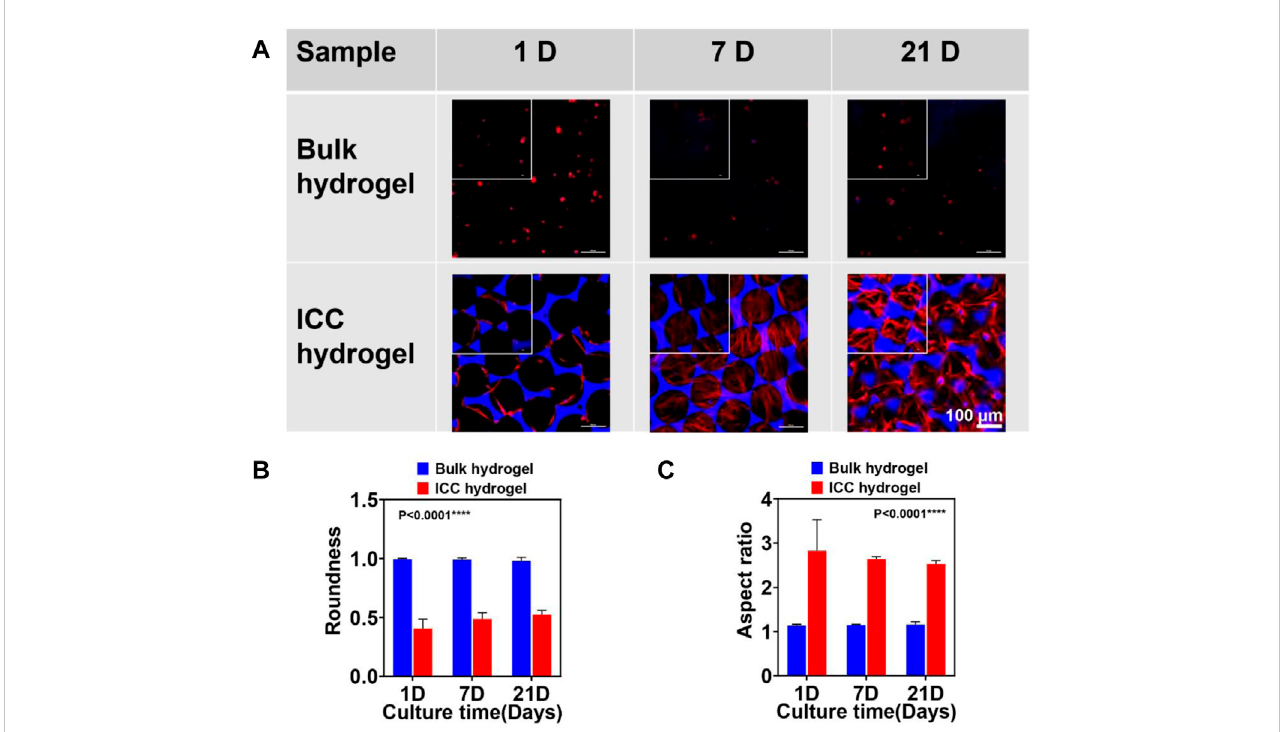
FIGURE 6 (A) Cell morphology in GelMA bulk and ICC hydrogels on different culture times (1, 7, and 21 days) con fi rmed via confocal microscopy. F-actin stained with Alexa Fluor 488 phalloidin (red) and nuclei stained with 4 ′ , 6-Diamidino-2-phenylindole dihydrochloride (DAPI, blue). Large window images (20 × lens; scale bar is 100 μ m). Small window images (40 × Lens, Scale bar is 100 μ m) (B,C) Cell roundness and aspect ratio were calculated from confocal microscope images using ImageJ.